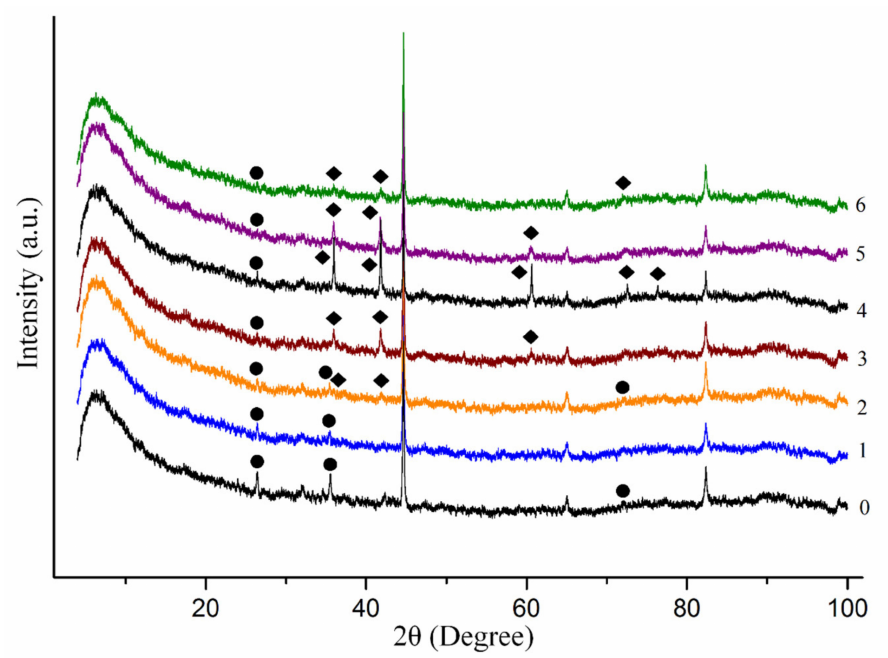
Figure 3. XRD patterns of the samples: 0—pure iron carbide Fe 3 C before reaction [28]; 1–6—solid products of the chemical reaction between Fe 3 C and H 2 O: at 873 K and 2.5 GPa (exp. #1), at 1023 K and 2.5 GPa (exp. #2), at 1023 K and 3.5 GPa (exp. #3), at 1123 K and 3.5 GPa (exp. #4), at 1123 K and 4.5 GPa (exp. #5), at 1223 K and 4.5 GPa (exp. #6); circles—characteristic peaks of Fe 3 C, diamonds—characteristic peaks of